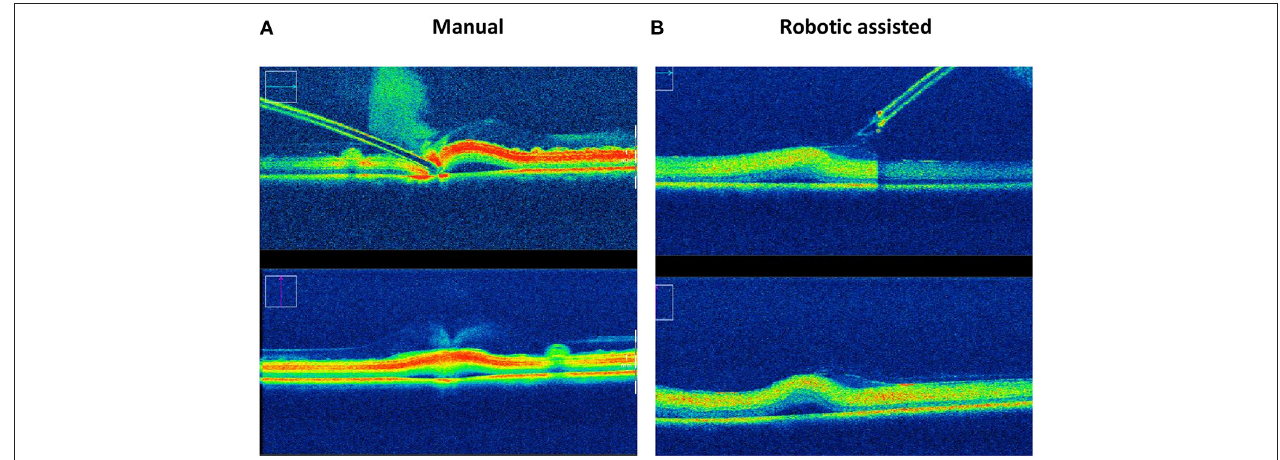
FIGURE 6 | Reflux and bleb formation as seen by intraoperative OCT in an ex-vivo porcine model using a solution containing a contrast agent. Intraoperative OCT pictures of subretinal injection using an assistive robotic system (B) reduces the incidence of reflux from 100 to 20% and increases the rate of successful bleb formation from 40 to 100% in this porcine eye model, as compared to manual subretinal injection (A)